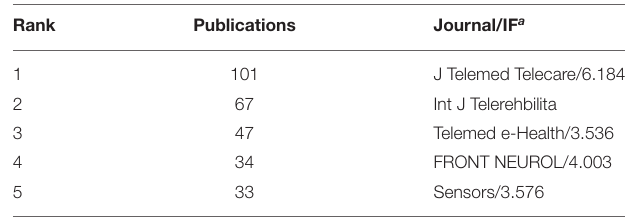
TABLE 1 | Top five most productive journals related to